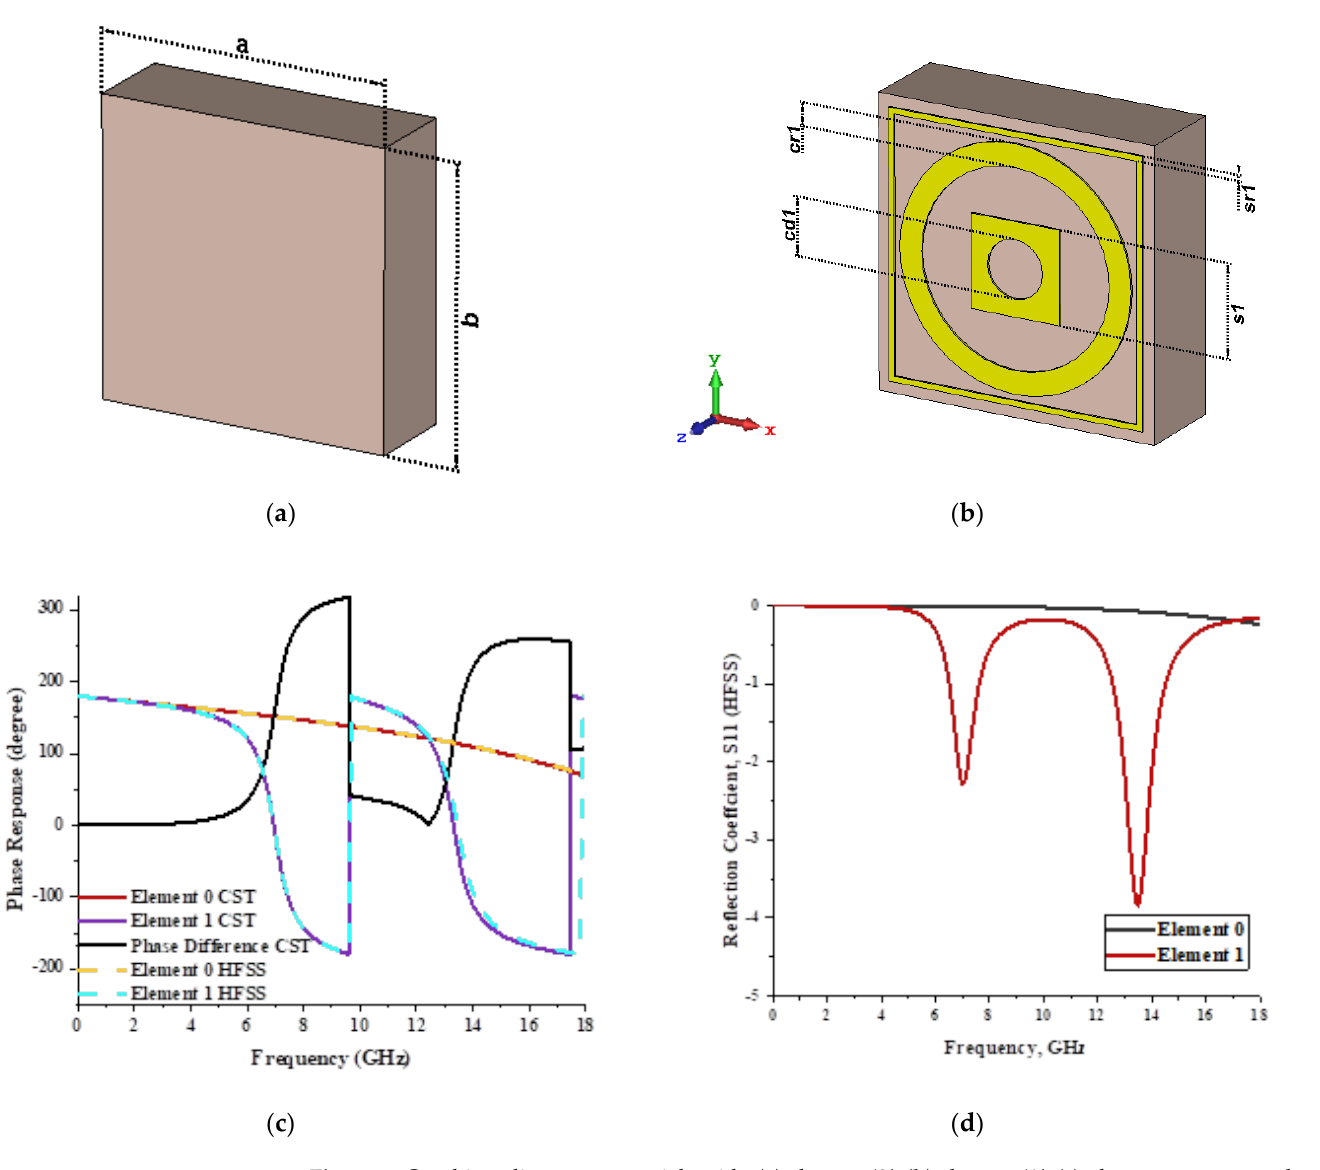
Figure 5. One-bit coding metamaterials with: ( a ) element ‘0’; ( b ) element ‘1’; ( c ) phase responses; and ( d ) S11 of both elements.